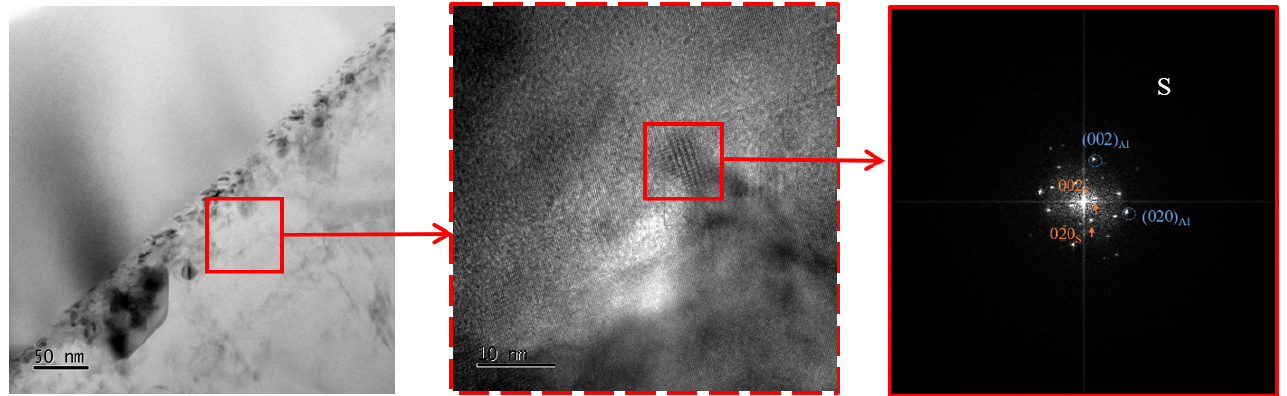
Figure 10. TEM and corresponding HRTEM images and fast Fourier transform (FFT) patterns of selected precipitates near grain boundaries in CHT-UA samples with identified S precipitates. The electron beam is parallel to [001] Al